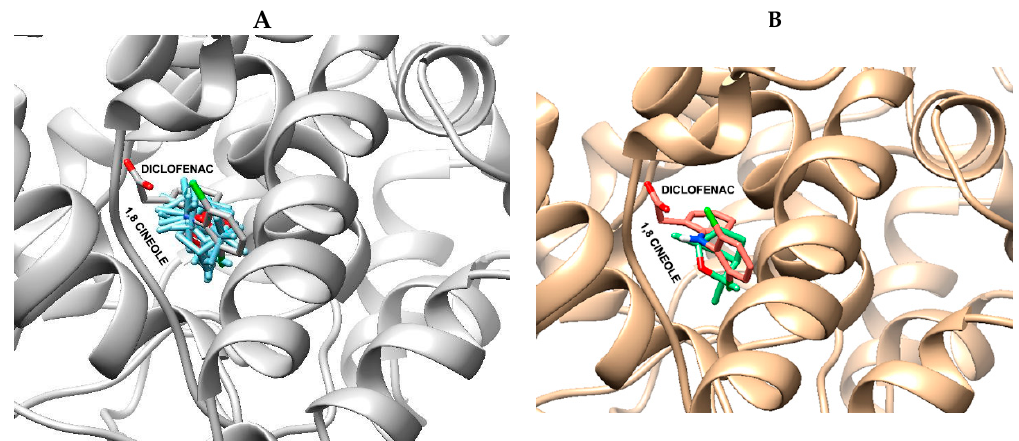
Figure 8. Docking of 1,8 cineole in the active site of COX-2 enzyme: ( A ) all conformations (blue stick) and diclofenac (gray stick) and ( B ) best binding conformations (green) and diclofenac (pink stick). Hydrogen atoms of the amino acid residues have been removed to improve clarity.